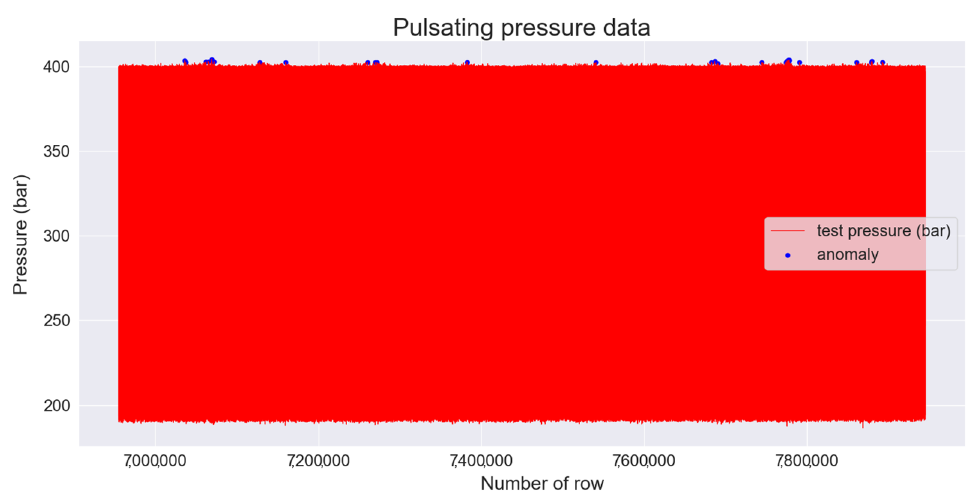
Figure 16. Anomaly detection graph based on the threshold of the LSTM autoencoder in the test set.